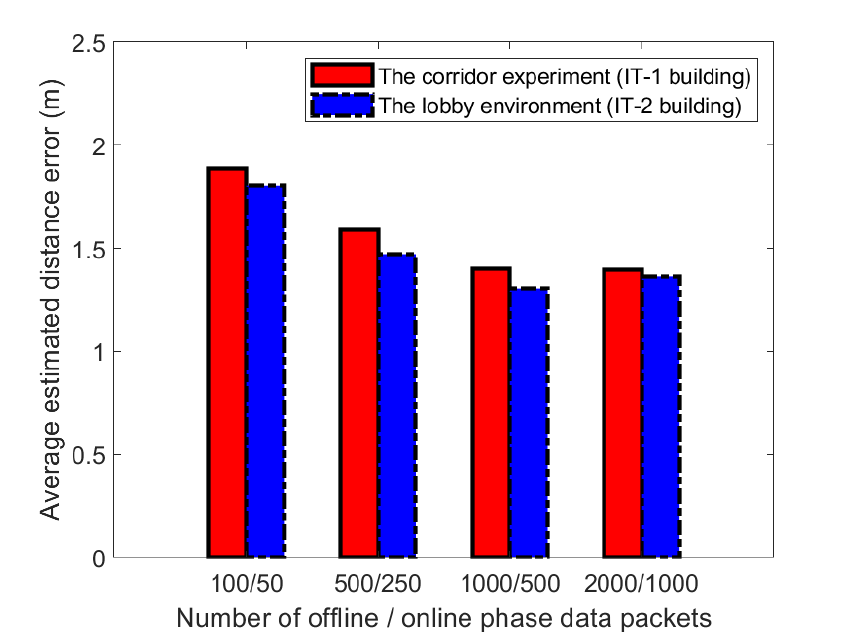
Figure 22. Distance estimation errors at reference points (1,1) in two different experimental environ- ments.